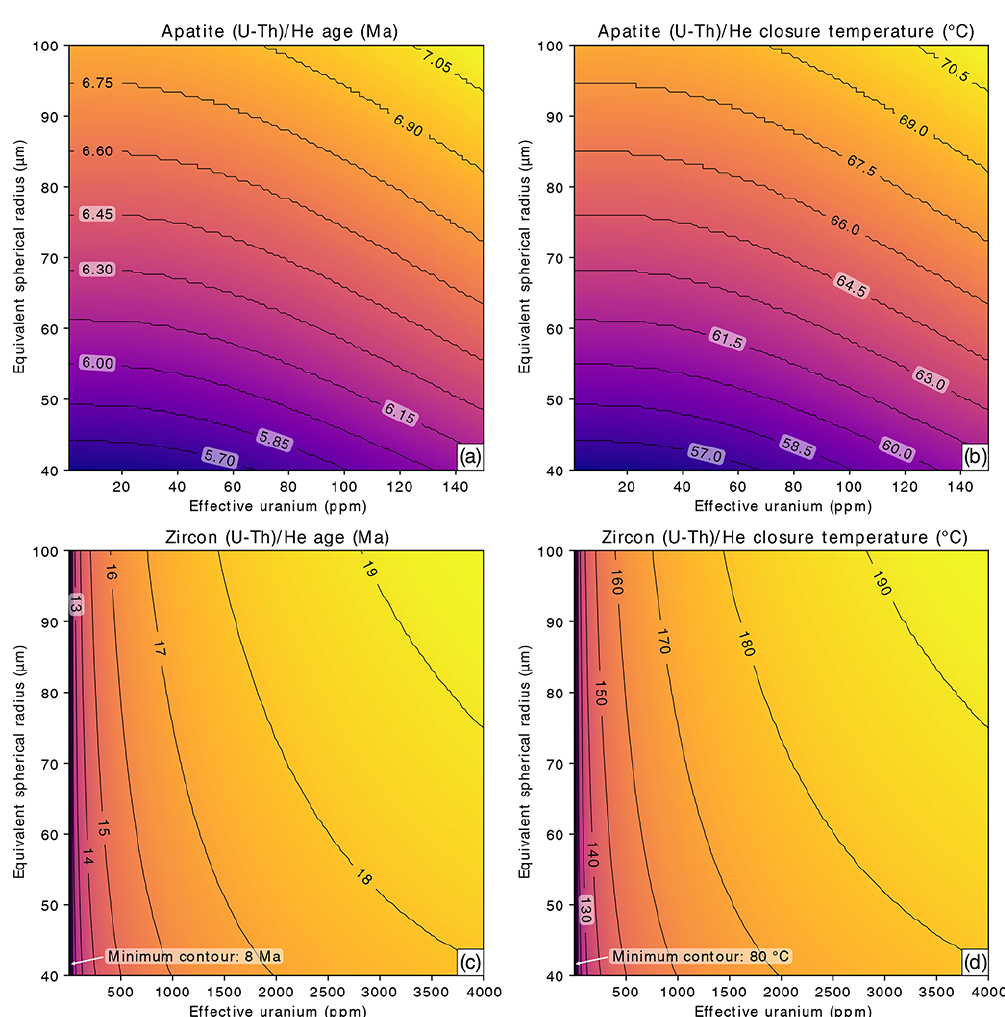
Figure 2. Contoured model (U-Th) / He cooling ages (a) and closure temperatures (b) for apatite and model (U-Th) / He cooling ages (c) and closure temperatures (d) for zircon of different effective spherical radii and eU concentrations (ppm). All panels are calculated for cooling from 350 to 0 ◦ C at a constant rate of 10 ◦ CMyr − 1 . The plots comprise predicted ages and closure temperatures for 10201 forward